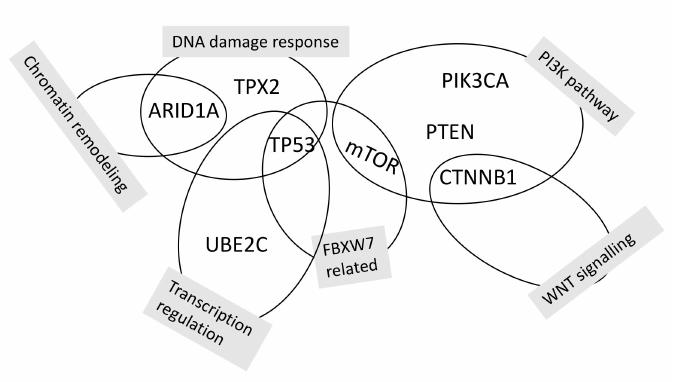
Figure 3. Functional grouping of candidate genes for potential risk stratification in early endometrial cancer